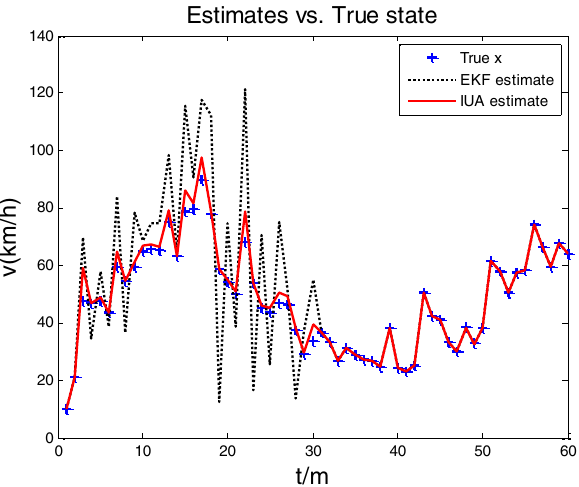
Figure 3. Comparison of estimation of IUA and EKF algorithms for traffic flow speed.